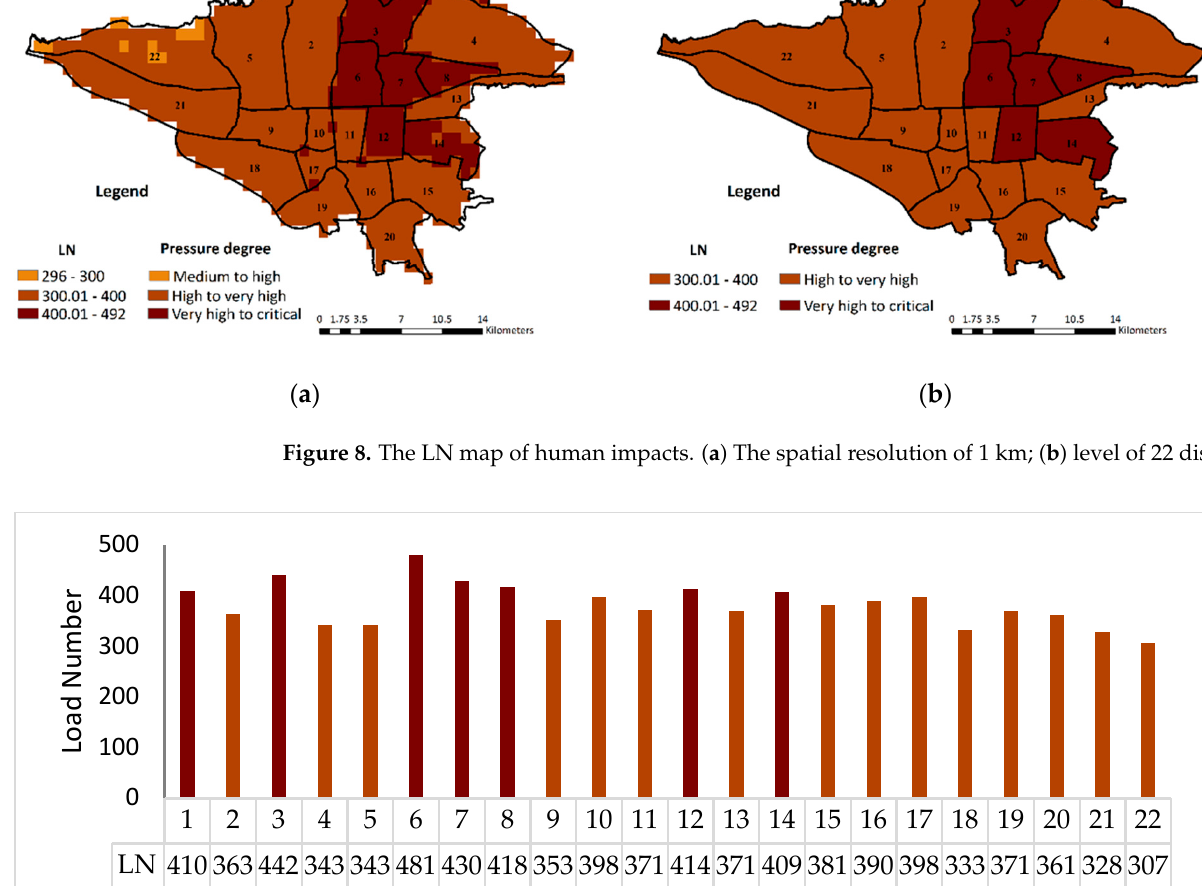
Figure 9. The LN graph of human impacts.